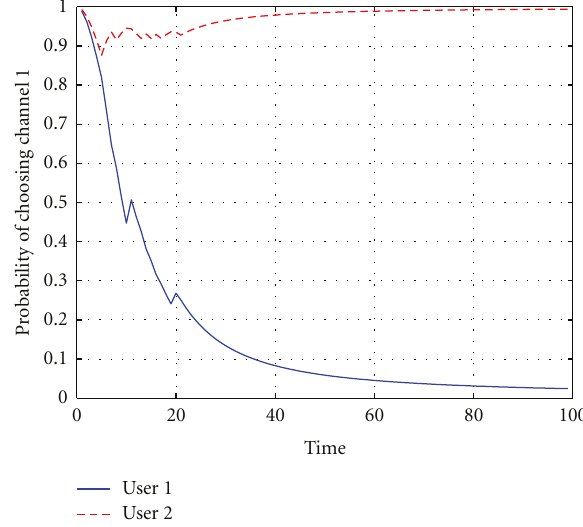
Figure 5: An example of dynamics of the Q -learning when N = 2, γ = 0 . 1, and system state is fully observable.